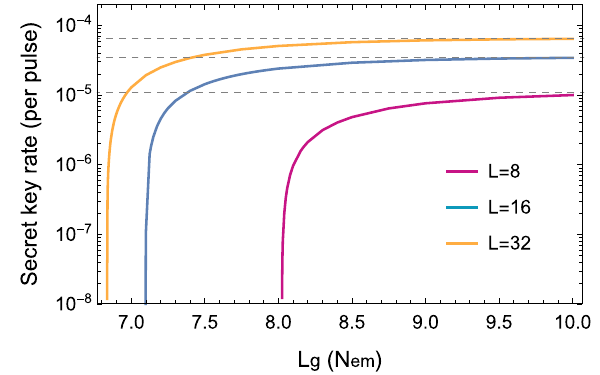
Fig. 2 Secret key rate R versus N em . The full lines show the secret key rate R versus N em for the RRDPS protocol when N em is fi nite. These lines from bottom to up with L = 8, 16, 32. The dashed lines represent the asymptotic results. The total security parameter of the = 10 − 10 . The channel loss is fi xed at 20 dB. Dark fi nal key is ϵ tot : counts rate is d = 10 − 6 per pulse, and the misalignment of measurement is e mis = 0.015. The ef fi ciency of error correction ξ is 1.1.